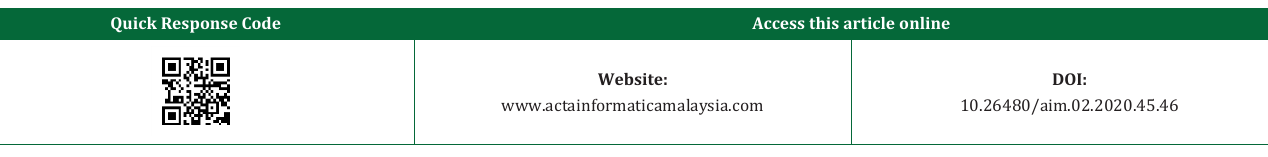
Figure 1: Effect of color image